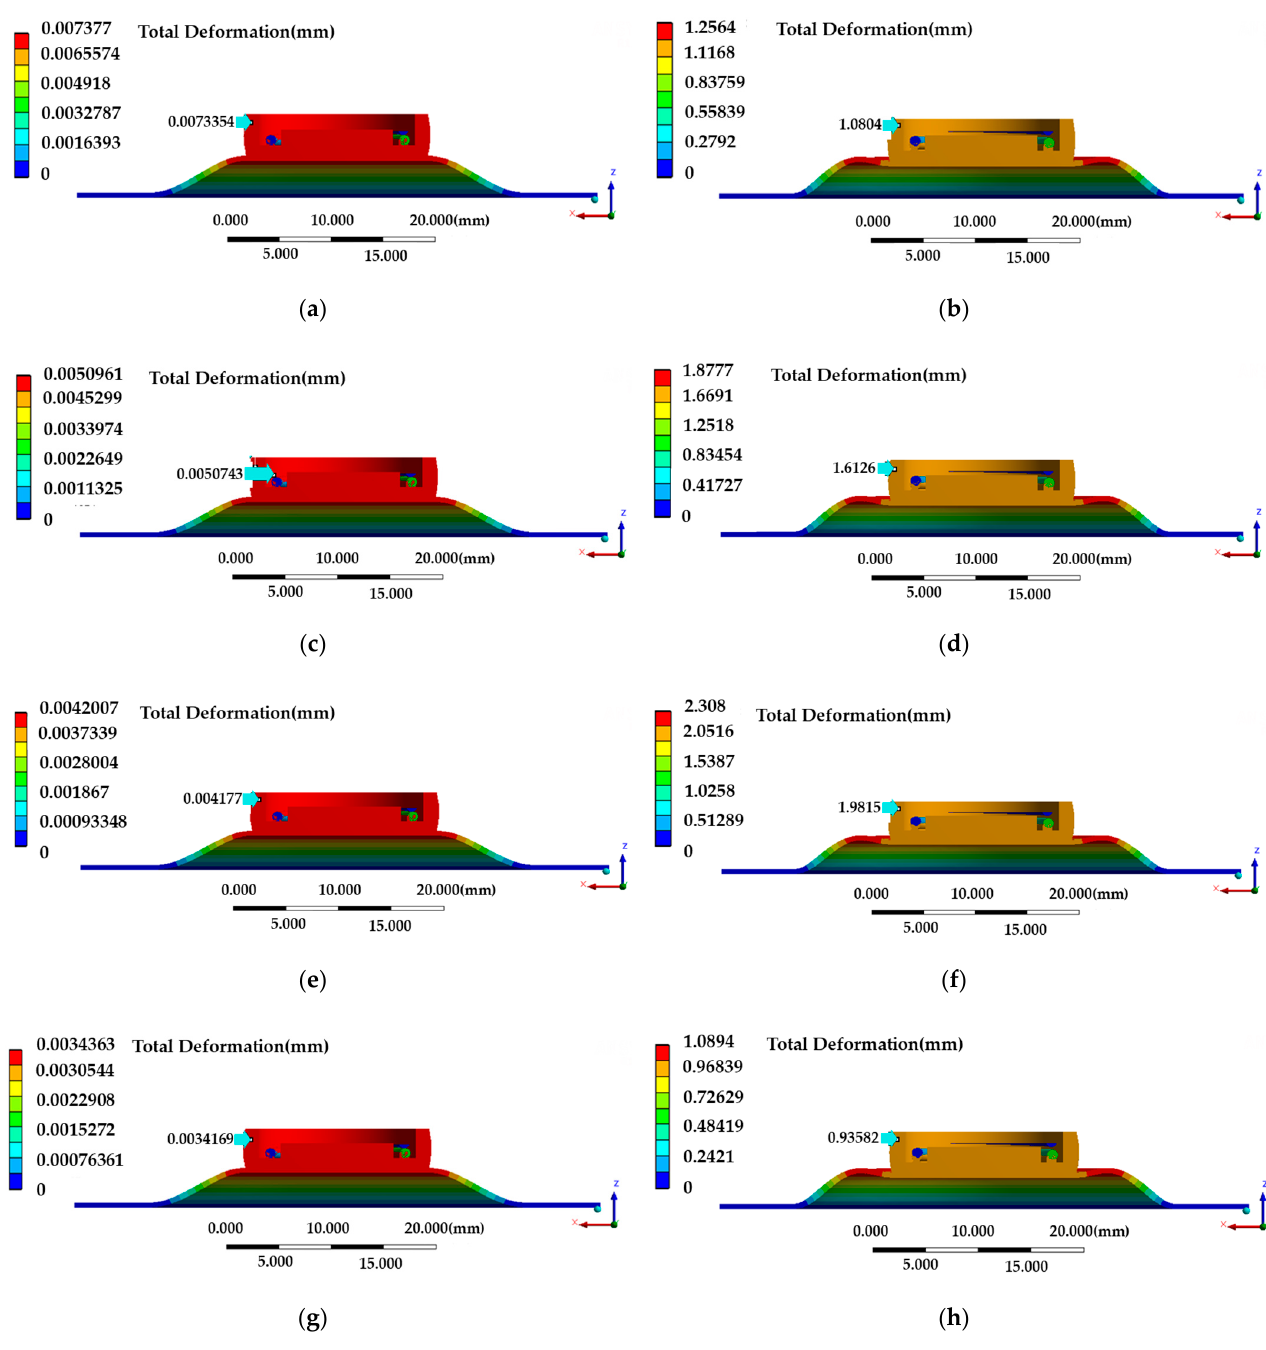
Figure 4. Deformation of membrane assembly with control pressure at different ambient pressures: ( a ) Both ambient pressure and control pressure are 0.10133 MPa; ( b ) The ambient pressure is 0.10133 MPa, and the control pressure is 0.107 MPa; ( c ) Both ambient pressure and control pressure are 0.07 MPa; ( d ) The ambient pressure is 0.07 MPa, and the control pressure is 0.08 MPa; ( e ) Both ambient pressure and control pressure are 0.0577 MPa; ( f ) The ambient pressure is 0.0577 MPa, and the control pressure is 0.07 MPa; ( g ) Both ambient pressure and control pressure are 0.0472 MPa; ( h ) The ambient pressure is 0.0472 MPa, and the control pressure is 0.053 MPa.